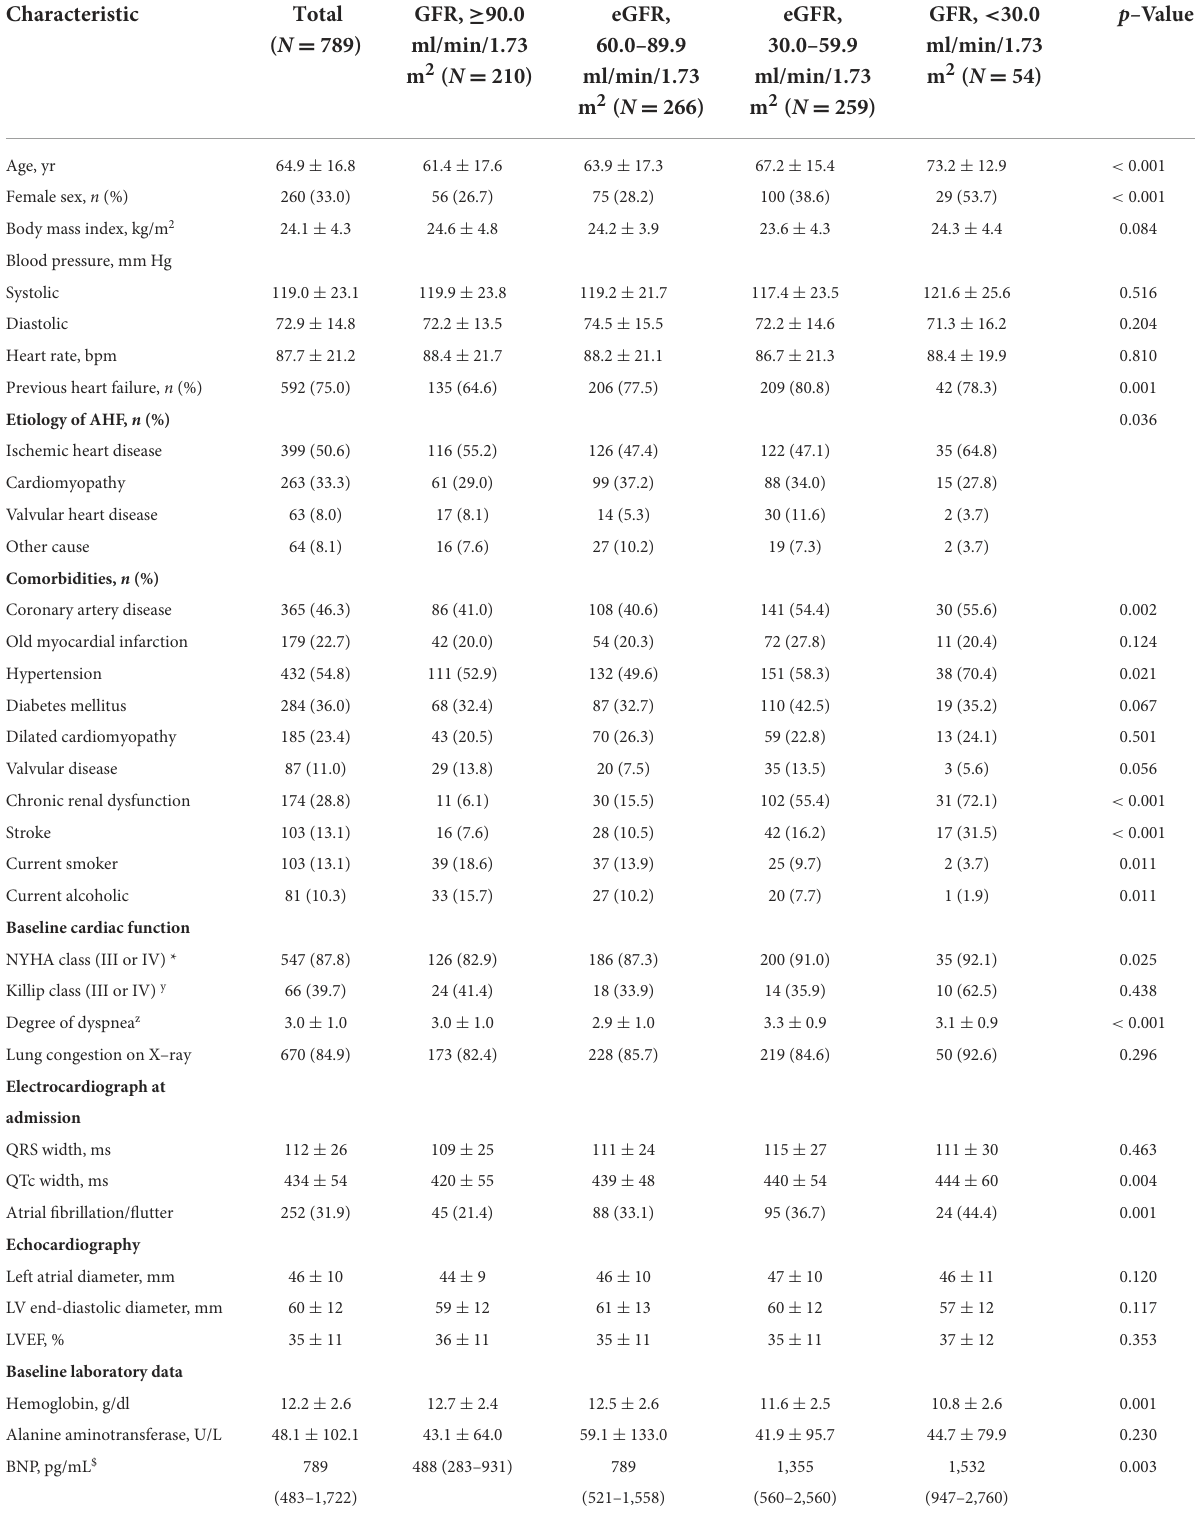
TABLE 1 Baseline characteristics of 789 AHF patients according to eGFR